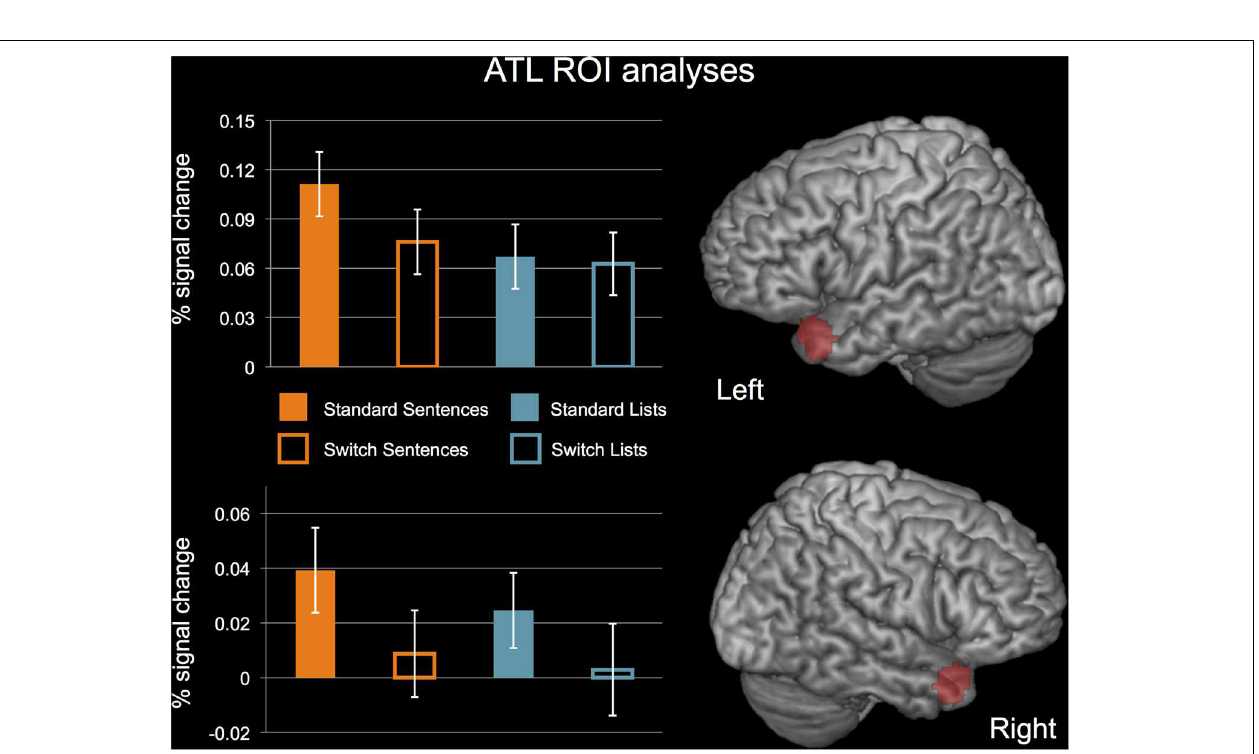
FIGURE 6 | ROI analyses for Broca’s area and the RIFG. N = 20. Error bars indicate standard error of the mean. See text for details of statistical analyses.